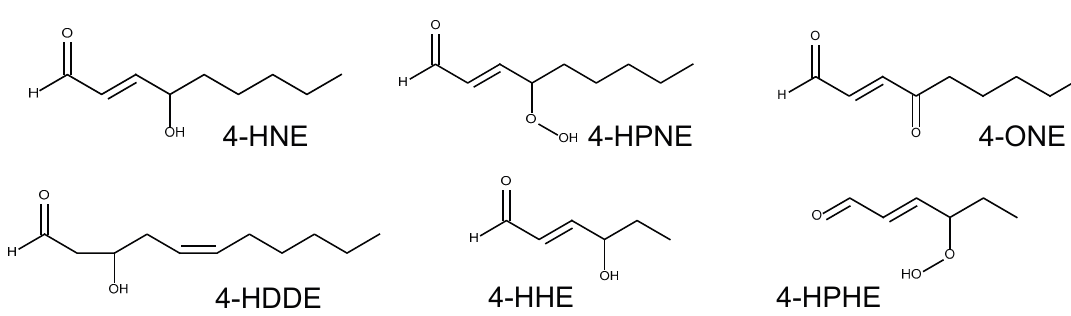
Figure 6. Hydroxy-2-nonenal (HNE) and related